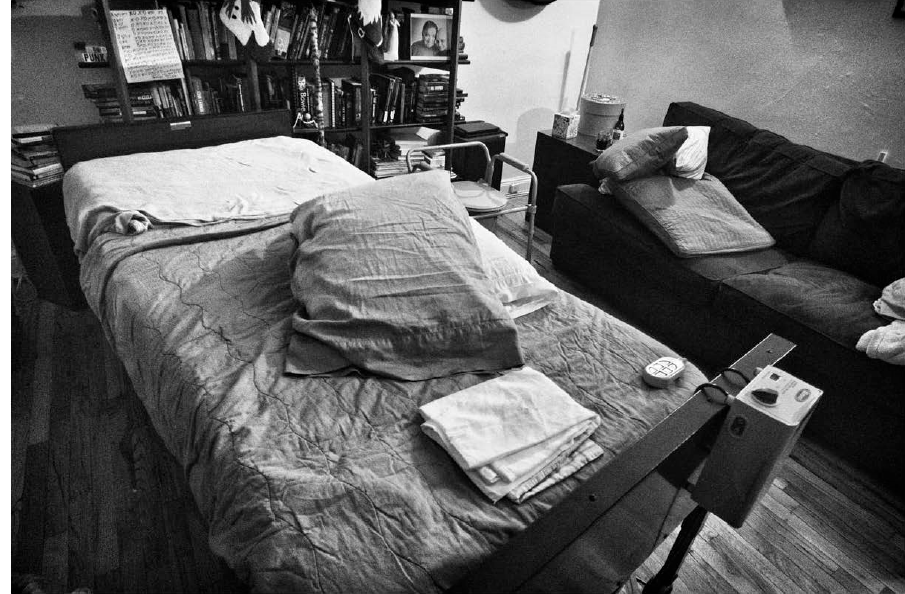
Figure 4. Courtesy Angelo Merendino, The Battle we Didn’t Choose—My Wife’s Fight with Breast Cancer .